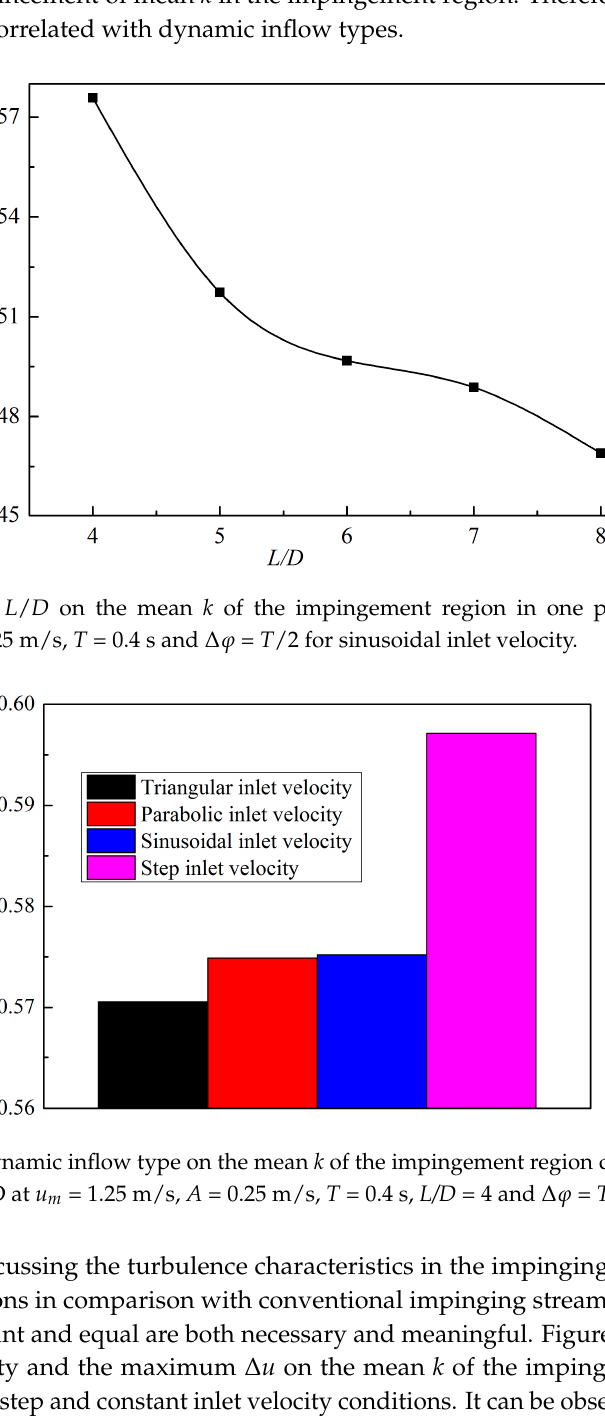
( b ) Figure 17. ( a ) Effect of amplitude on the mean k of the impingement region during one period, as determined by CFD for sinusoidal step inlet velocity, u m = 1.25 m/s, T = 0.4 s, L / D = 4 and ∆ (cid:2030) = T /2. ( b ) Effect of phase difference, as determined by CFD, on the mean k of the impingement region in one period for sinusoidal step inlet velocity, u m = 1.25 m/s, T = 0.4 s, L / D = 4 and A = 0.25 m/s. Figure 17b shows the effect of phase difference on the mean k of the impingement region, as determined using CFD. It can be observed from Figure 17b that the mean k of the impingement region reaches their maximum values with the variation of ∆ (cid:2030) . The value of ∆ (cid:2030) increases when the maximum ∆ u of the sinusoidal inlet velocity rises at constant w , which causes an enhancement of the velocity fluctuation in the impinging zone. By contrast, u * increases when ∆ (cid:2030) decreases, resulting in a more violent impinging force of the dynamic flow field. Therefore, the mean k of the impingement region reaches their maximum values at ∆ (cid:2030) ≈ T /6 . On the basis of these analyses and results, ∆ u and